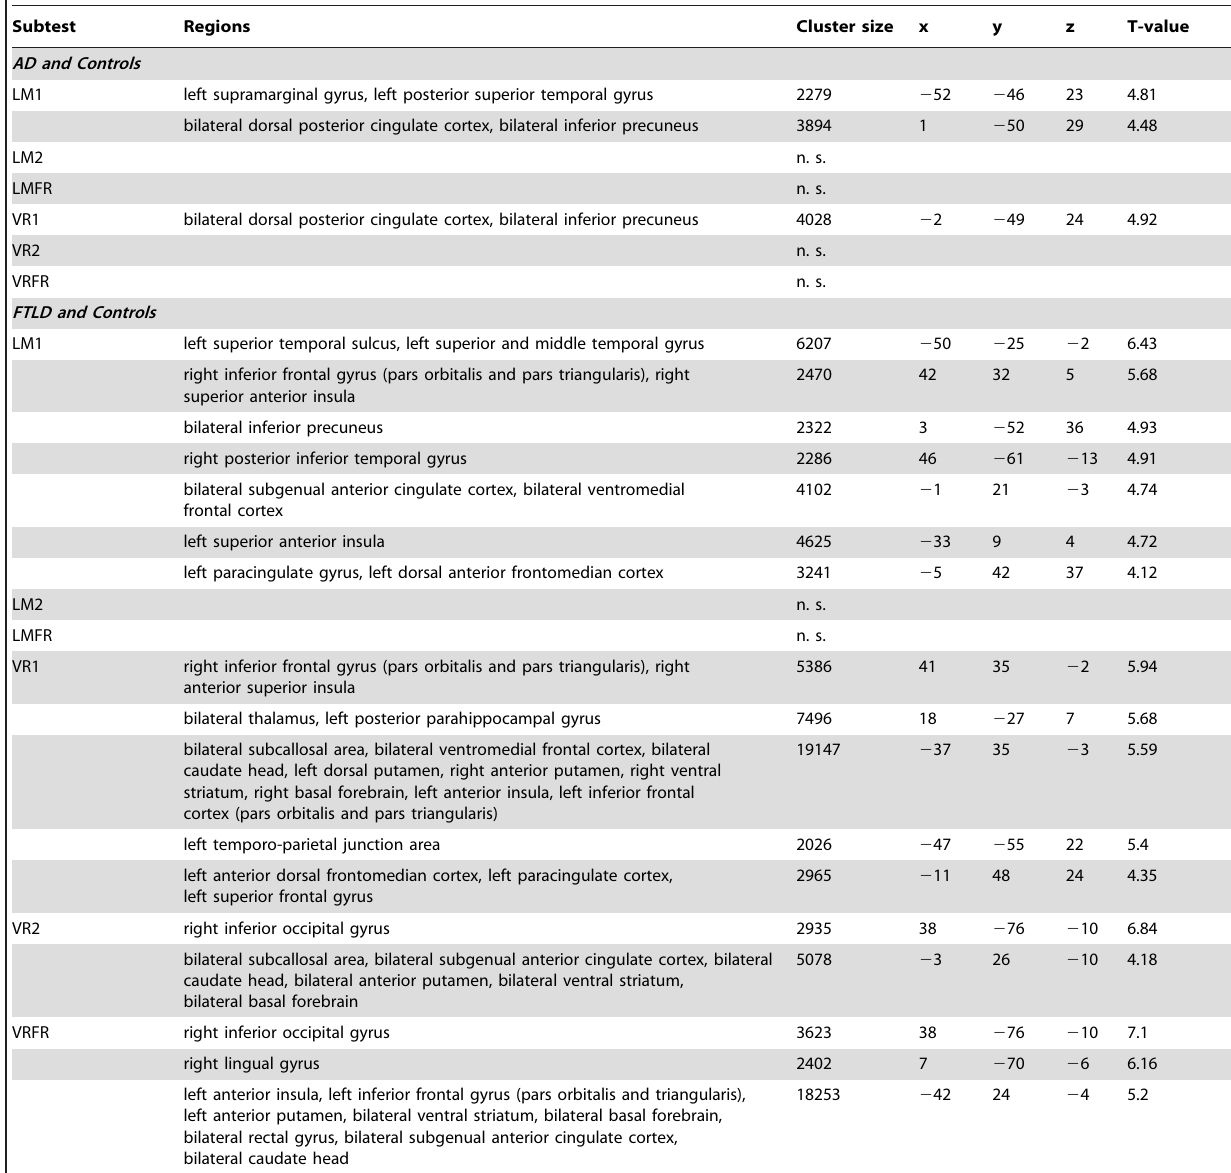
Statistical results for the correlations between each memory measure and atrophy (MRI) for AD patients and controls as well as FTLD patients and controls. Cluster size is reported in voxels, voxel size was 1 6 1 6 1 mm.